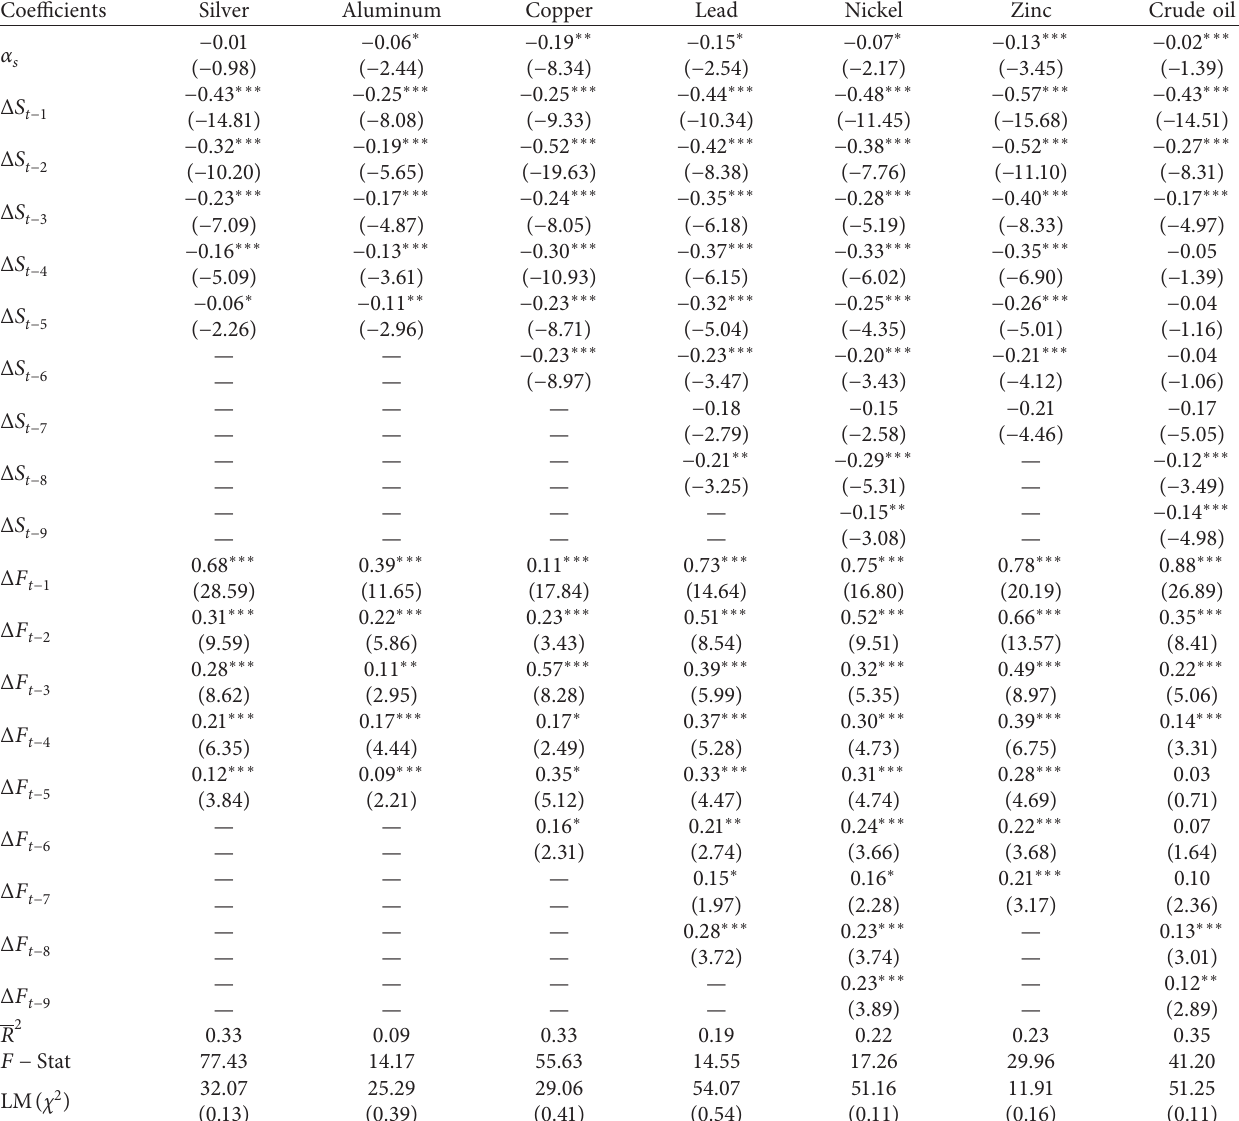
Table 9: Vector error correction model for spot price of the selected commodities.